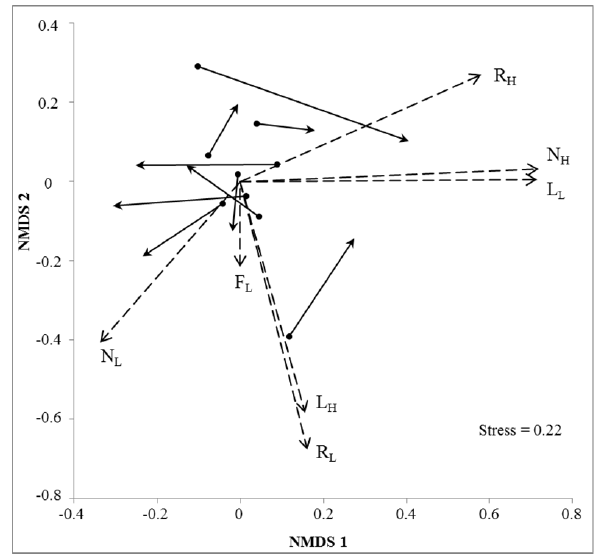
Figure 2. Two-dimensional NMDS diagram of the shift in herb layer composition of oak-hornbeam forests in the Western Bieszczady Mountains between the 1950s and 2000s. The shifts between sampling periods are indicated by the arrows. Dashed vectors indicate ecological groups of species with a high relationship with NMDS scores. See Table 1 for details of the dashed vectors. Table 1. Spearman rank correlations ( n = 18) between 1 and 2 axes of non metric multidimensional scaling (NMDS) analysis of herb species and ecological groups of species (groups of species with EIV ≤ 3; L L , F L , R L , N L , and with EIV ≥ 7; L H , F H , R H , N H ; for full explanation of abbreviations refer to Section 2.2.).